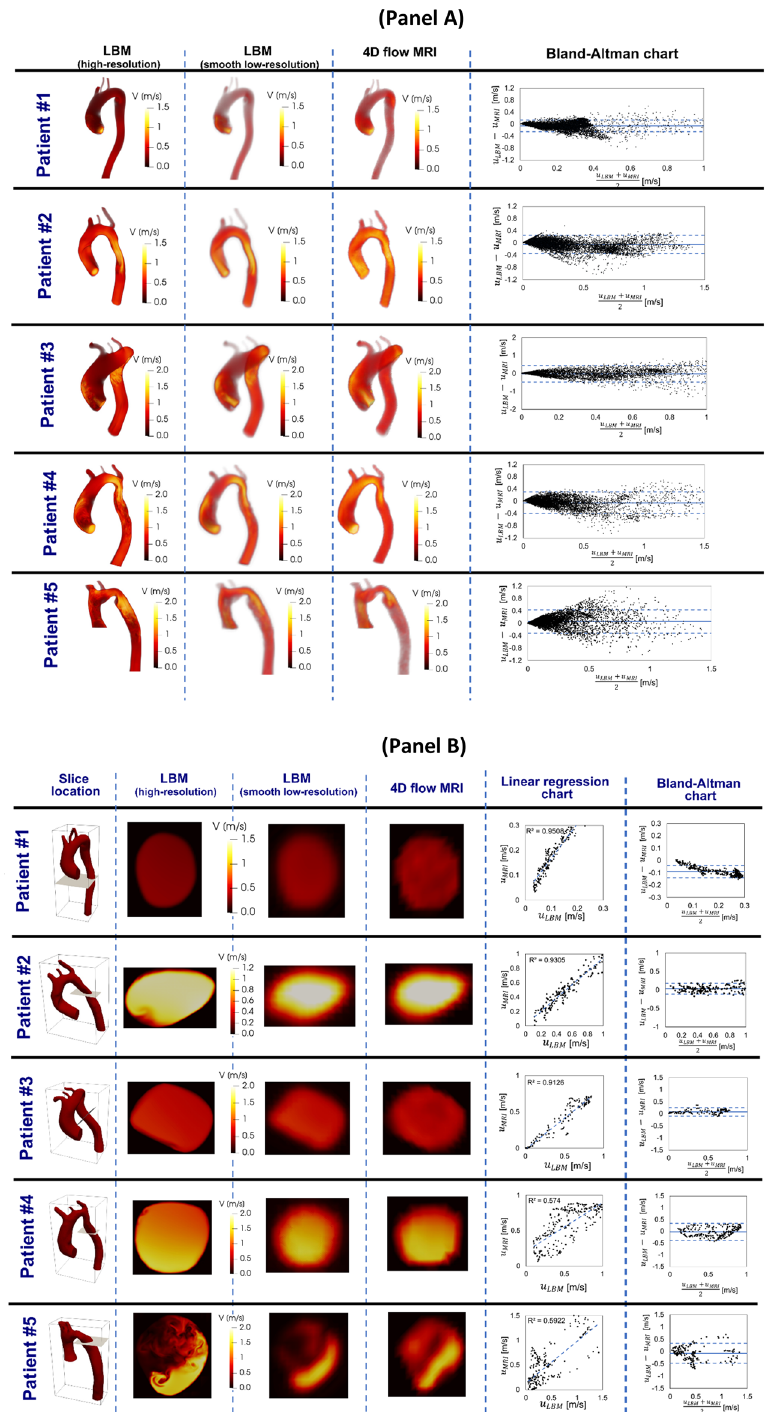
Figure 2. Validation against 4-D flow MRI. ( a ) We compared 4-D flow MRI data and results of the computational framework (based on lumped parameter model (LPM) and Lattice Boltzmann model (LBM)) in Patients #I to #V. ( a ) qualitatively (revealed in velocity mapping) and quantitatively by performing Pearson’s product moment correlation analysis on the entire domain at peak systole between smooth down-sampled LBM and 4D flow MRI measurements; ( b ) qualitatively (revealed in velocity mapping) and quantitatively by performing linear regression and Pearson’s product moment correlation analysis at sample cross sections at peak systole between smooth down-sampled LBM and PC-MRI